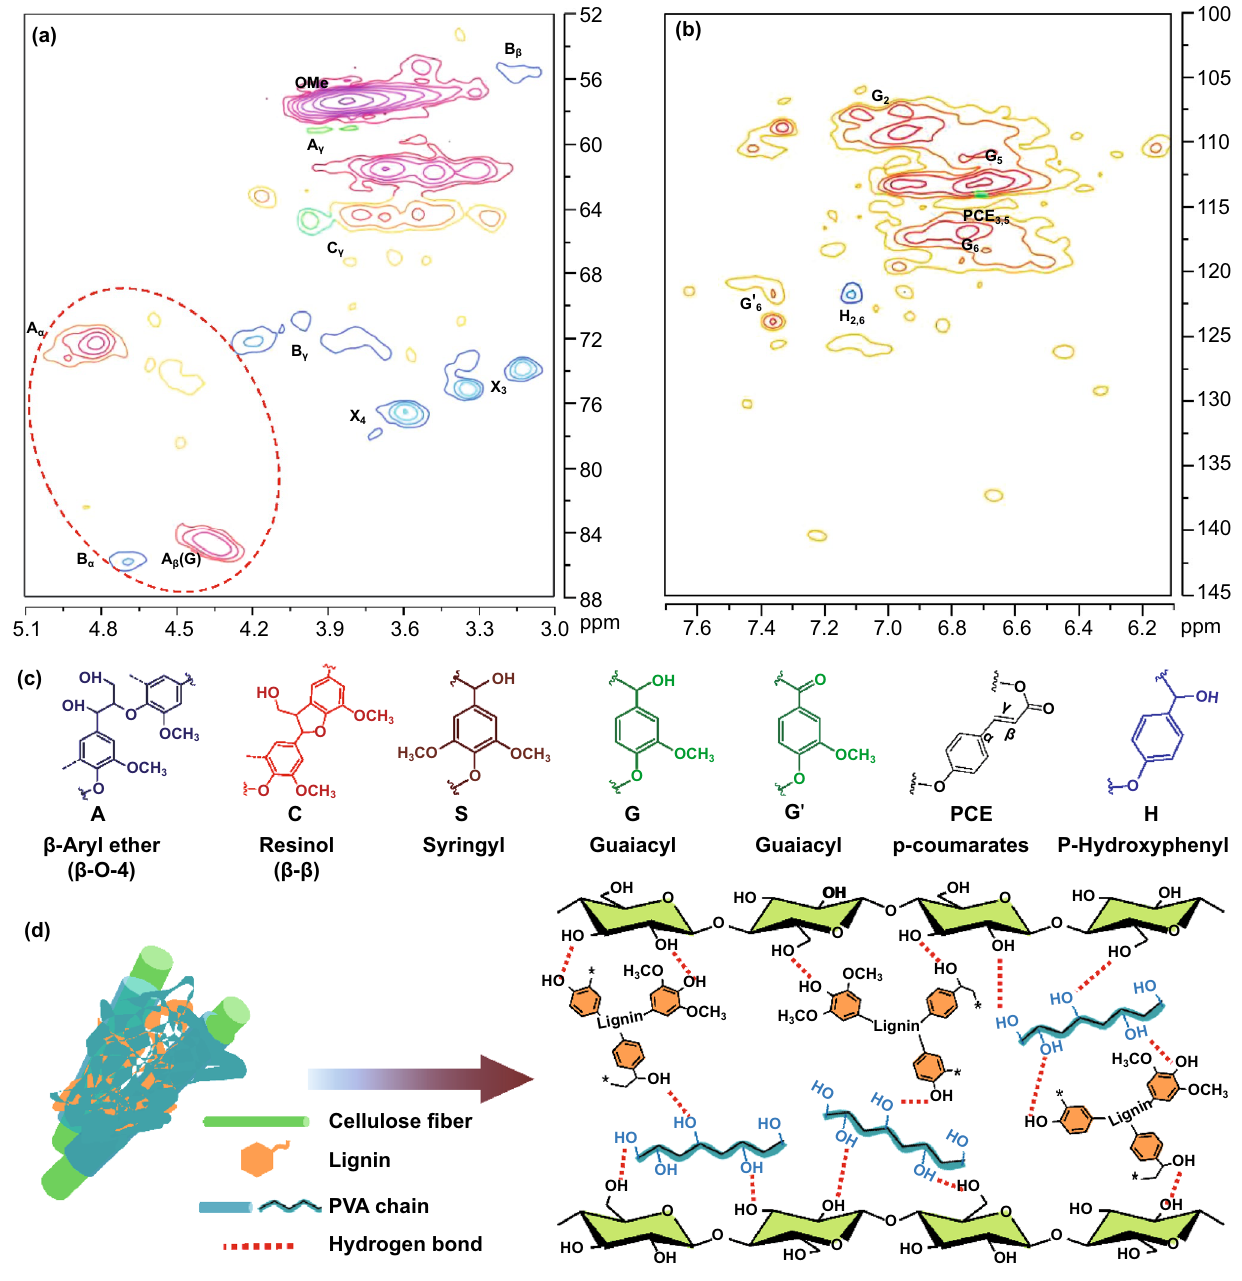
Fig. 3 The chemical structure properties of the lignin. The NMR spectra of regenerated lignin: a aliphatic regions ( δ C / δ H 52–88/3.0–5.1), and b aromatic regions ( δ C / δ H 100–145/6.1–7.7). c The functional groups contained in the lignin molecules. d The structural linkage between cellulose fibers, lignin molecules, and PVA